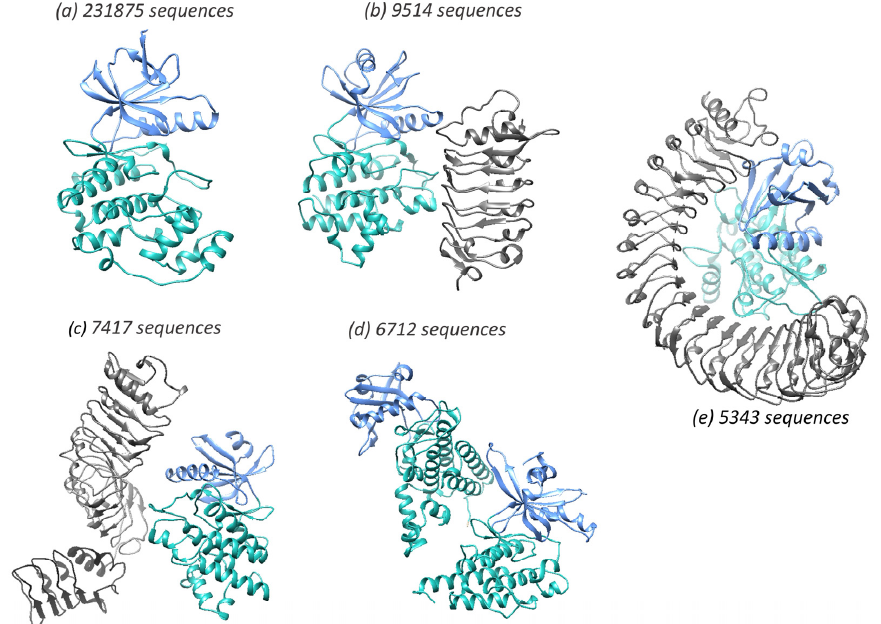
Figure 4. The most populated kinase multidomain architectures containing >5000 kinase sequences are shown. N-lobe is shown in blue, and the C-lobe is shown in cyan. The accessory domain is shown in grey. The domain architectures are illustrated using Alphafold2 structures from the following